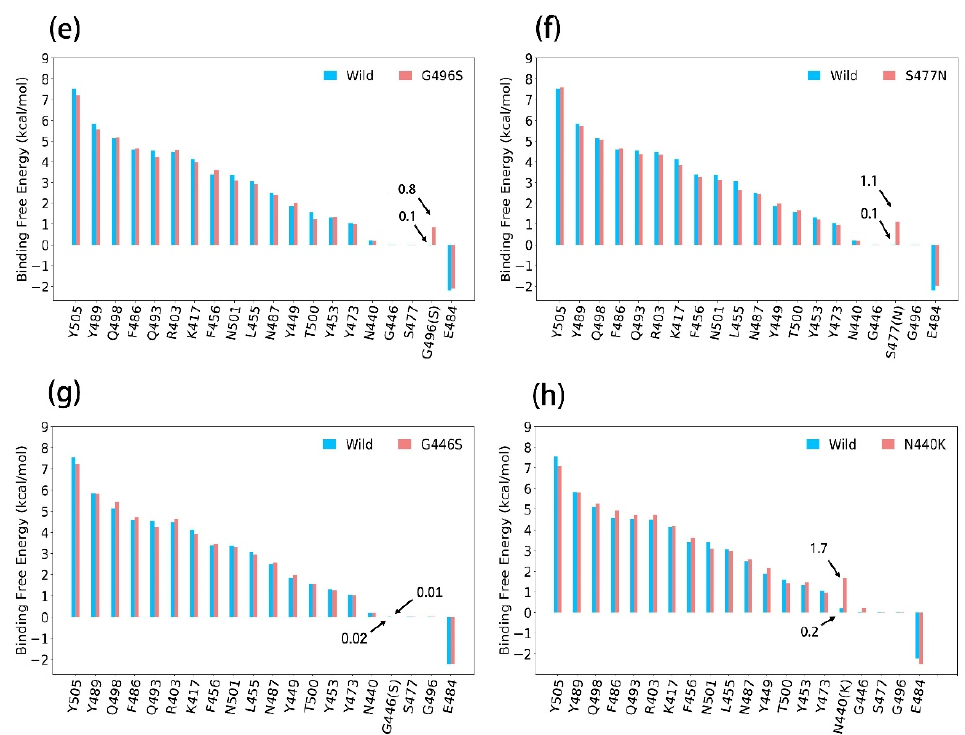
Figure 5. Residue-specific binding free energy data of the S protein between the wild type and the different mutants in binding to ACE2 from the ASGB calculation. (Calculated results were averaged over 5 trajectories separately). ( a – h ) show the specific binding affinity contributions of interface residues on S protein for wild type and Y505H, Q498R, Q493K, E484A, G496S, S477N, G446S and N440K complex.